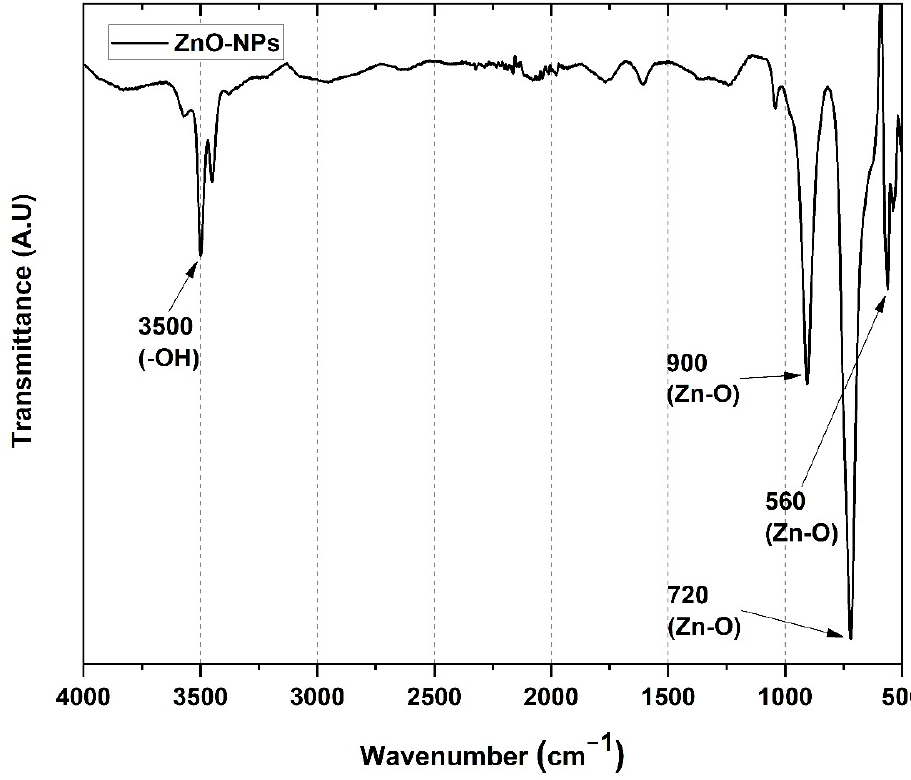
Figure 1. FT − IR spectrum for the ZnO-NPs.